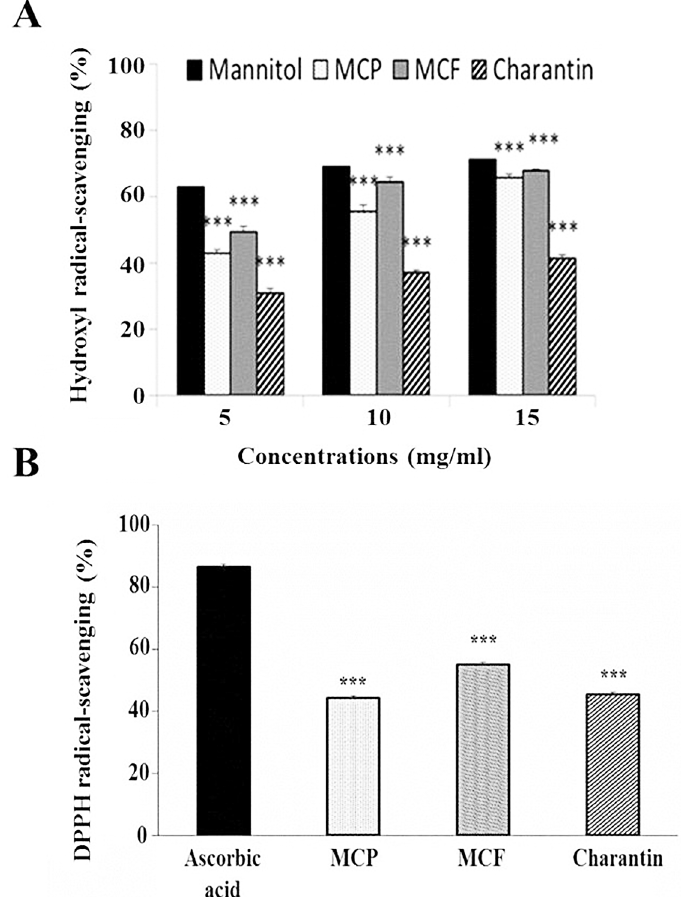
Fig 3. Radical scavenging activity of different concentrations of MCP, MCF and charantin. (A) The hydroxyl radical scavenging activity of 5 – 15 mg/ml extracts of MCP, MCF and charantin was assessed by monitoring the hydroxylation of salicylate by the Fe 3+ -salicylate-H 2 O 2 system over a period of 30 minutes at 37°C. Mannitol was used as a positive control. (B) The DPPH radical scavenging activity of 15 mg/ml extracts of MCP, MCF and charantin at 37°C over a period of 30 minutes was also assessed. Ascorbic acid was used as a positive control. All results are presented as mean ± SD (n = 3). *** : p < 0.001 vs